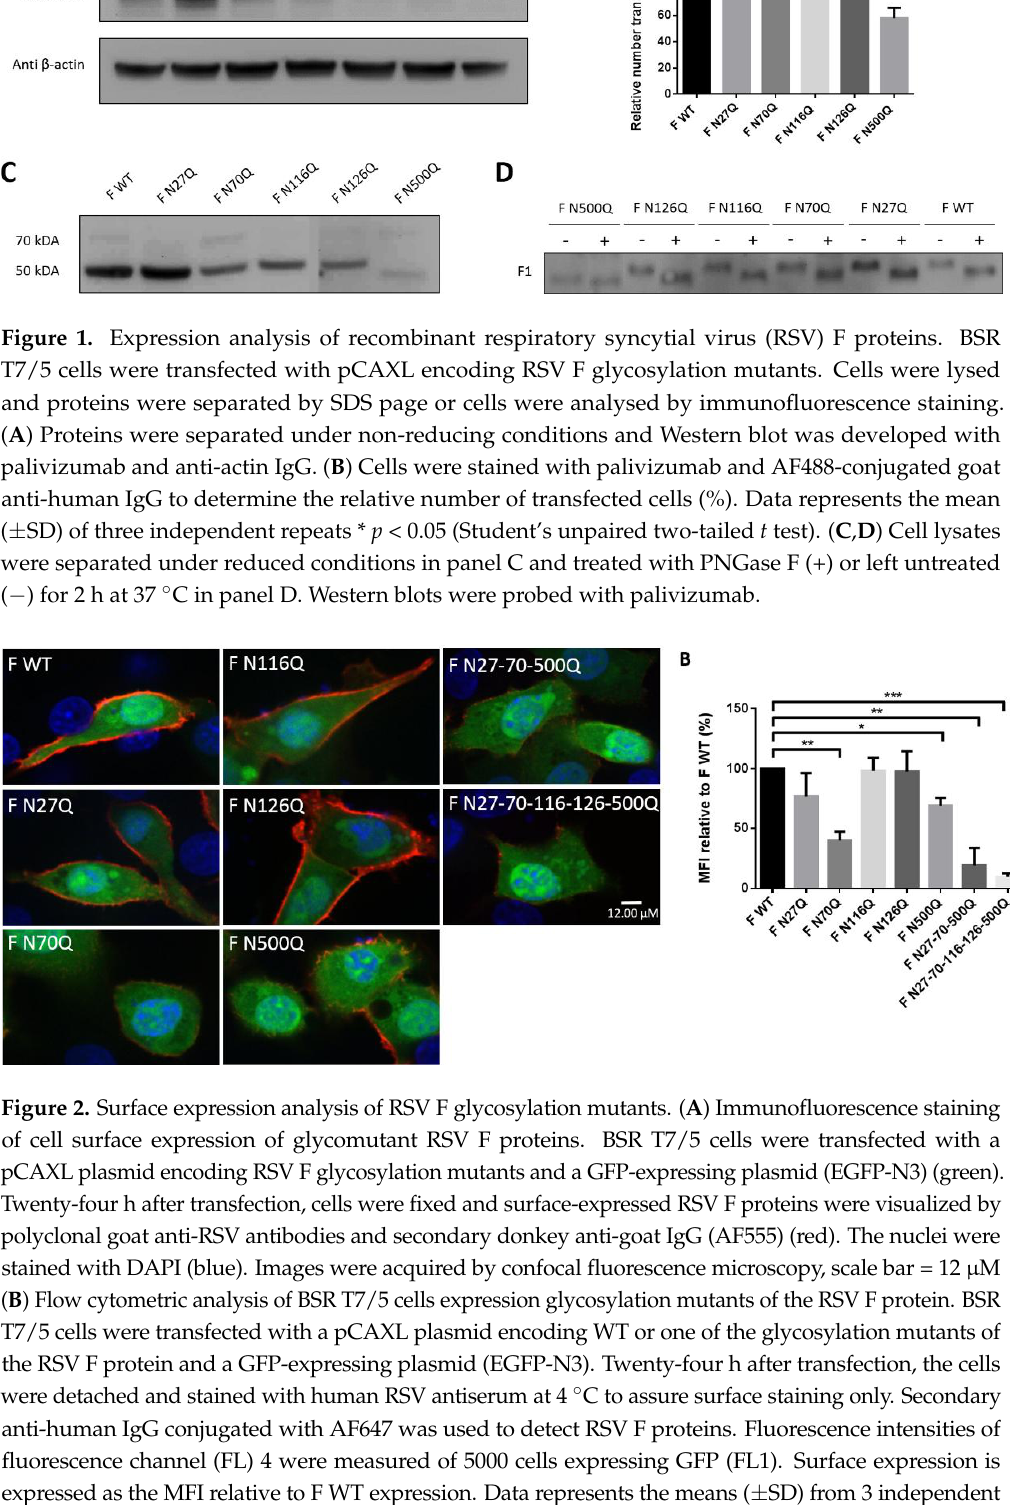
Figure 1 . Expression analysis of recombinant respiratory syncytial virus (RSV) F proteins. BSR T7/5 cells were transfected with pCAXL encoding RSV F glycosylation mutants. Cells were lysed and proteins were separated by SDS page or cells were analysed by immunofluorescence staining. ( A ) Proteins were separated under non-reducing conditions and Western blot was developed with palivizumab and anti-actin IgG. ( B ) Cells were stained with palivizumab and AF488-conjugated goat anti-human IgG to determine the relative number of transfected cells (%). Data represents the mean (±SD) of three independent repeats * p < 0.05 (Student’s unpaired two-tailed t test). ( C , D ) Cell lysates were separated under reduced conditions in panel C and treated with PNGase F (+) or left untreated (−) for 2 h at 37 °C in panel D. Western blots were probed with palivizumab.